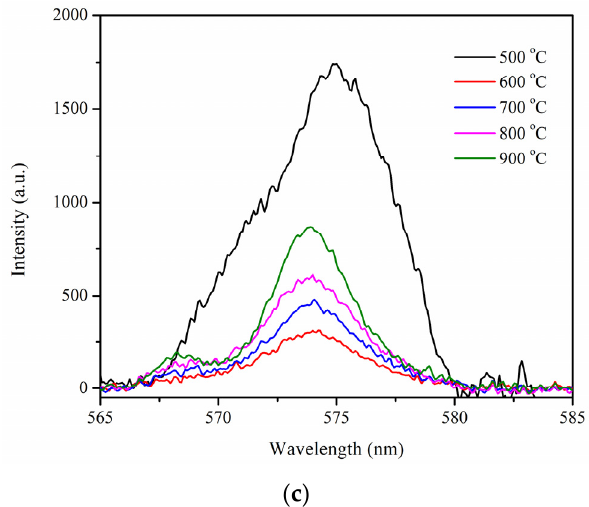
Figure 9. ( a ) Photocatalytic H 2 evolution; ( b ) UV-DRS spectrum; ( c ) photoluminescence spectra for Pr-LaFeO 3 treated at different calcination temperatures with 0.5 wt.% RhCrO x cocatalyst.